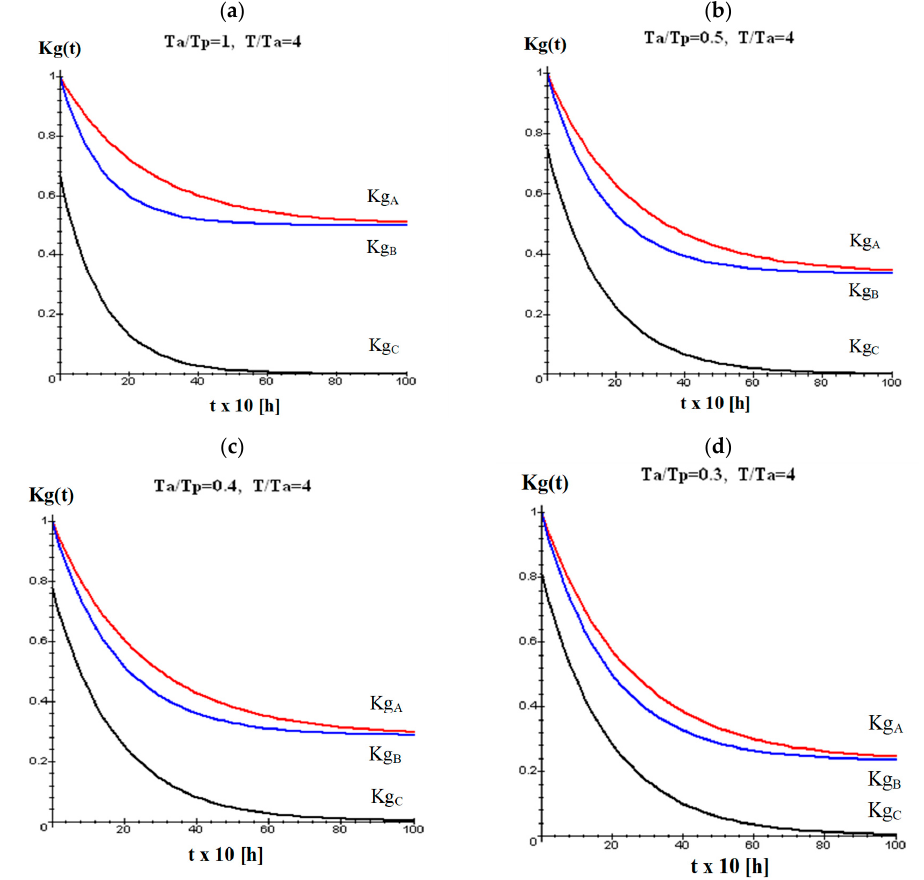
Figure 7. Courses of readiness function K g (t) in the operation process of wind power plant which uses various models of maintenance systems for condition T/T a = 4. Symbol in the Figure 5. represent: